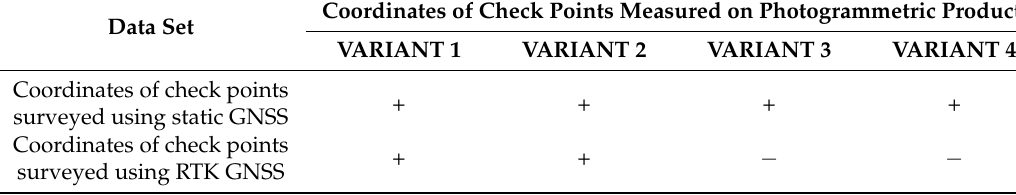
Table 7. List of data analysis performed on